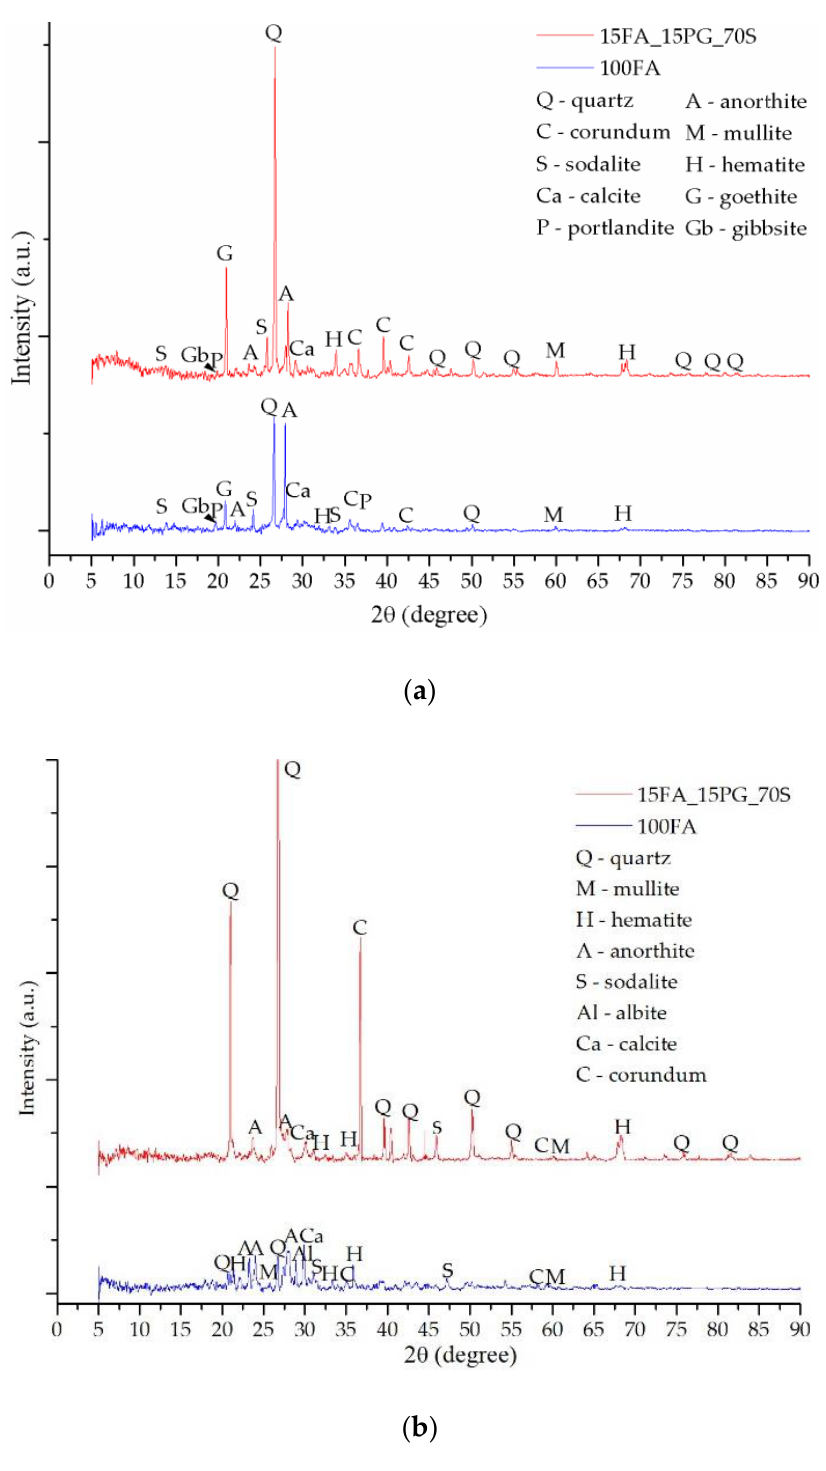
Figure 10. XRD patterns of sample 100FA and sample 15FA_15PG_70S: ( a ) prior TG-DTA analysis; ( b ) after TG-DTA analysis.